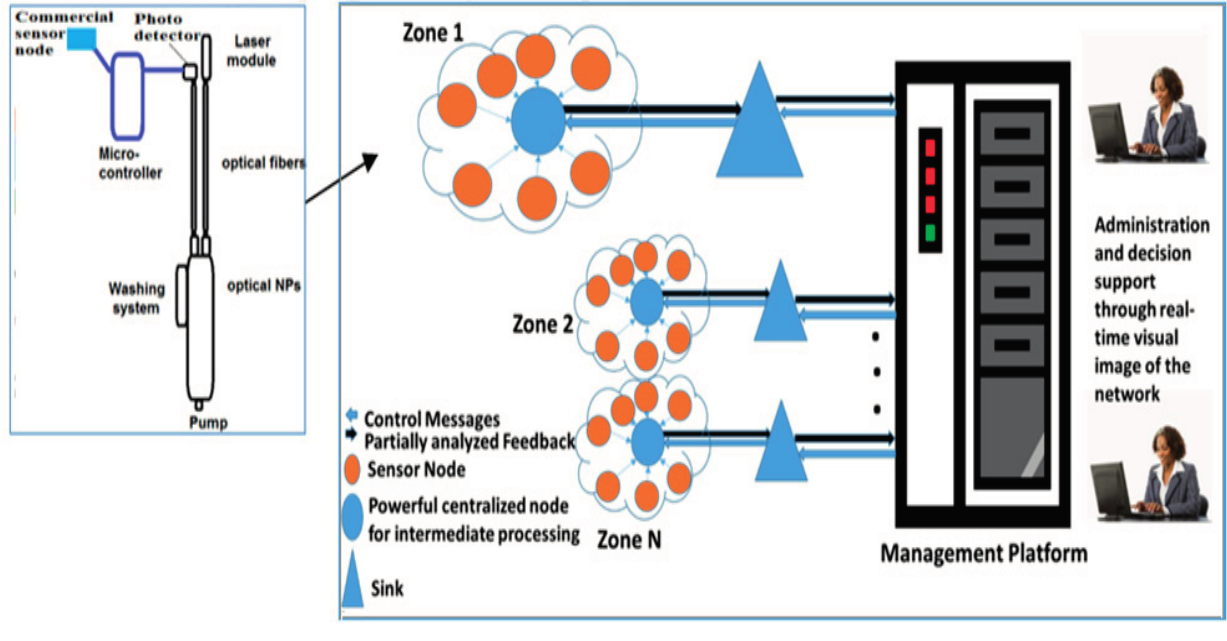
Figure 2. The sensing